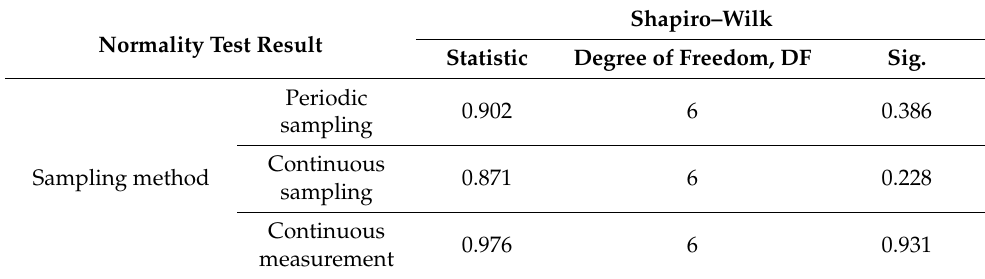
Table 7. The result of normality test by CH 4 emission factor about sampling method.